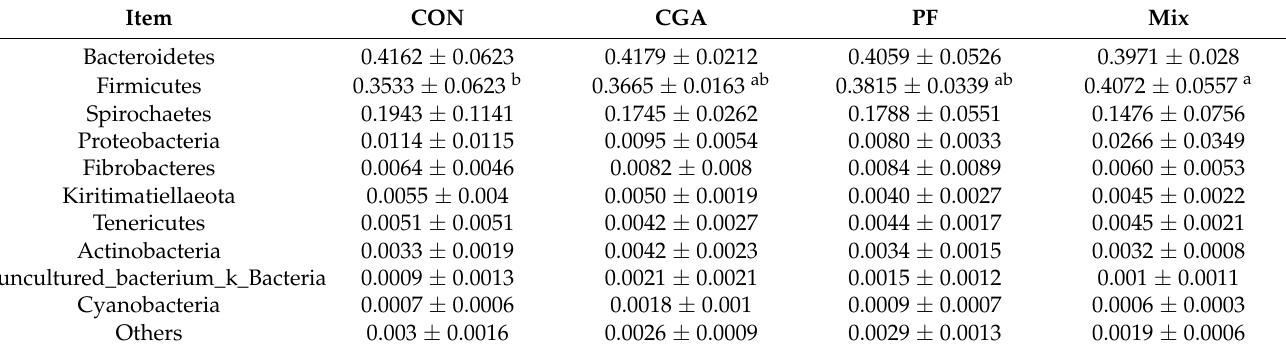
Table 4. Annotation and taxonomic analysis of rectal species in finishing pigs (genus level).